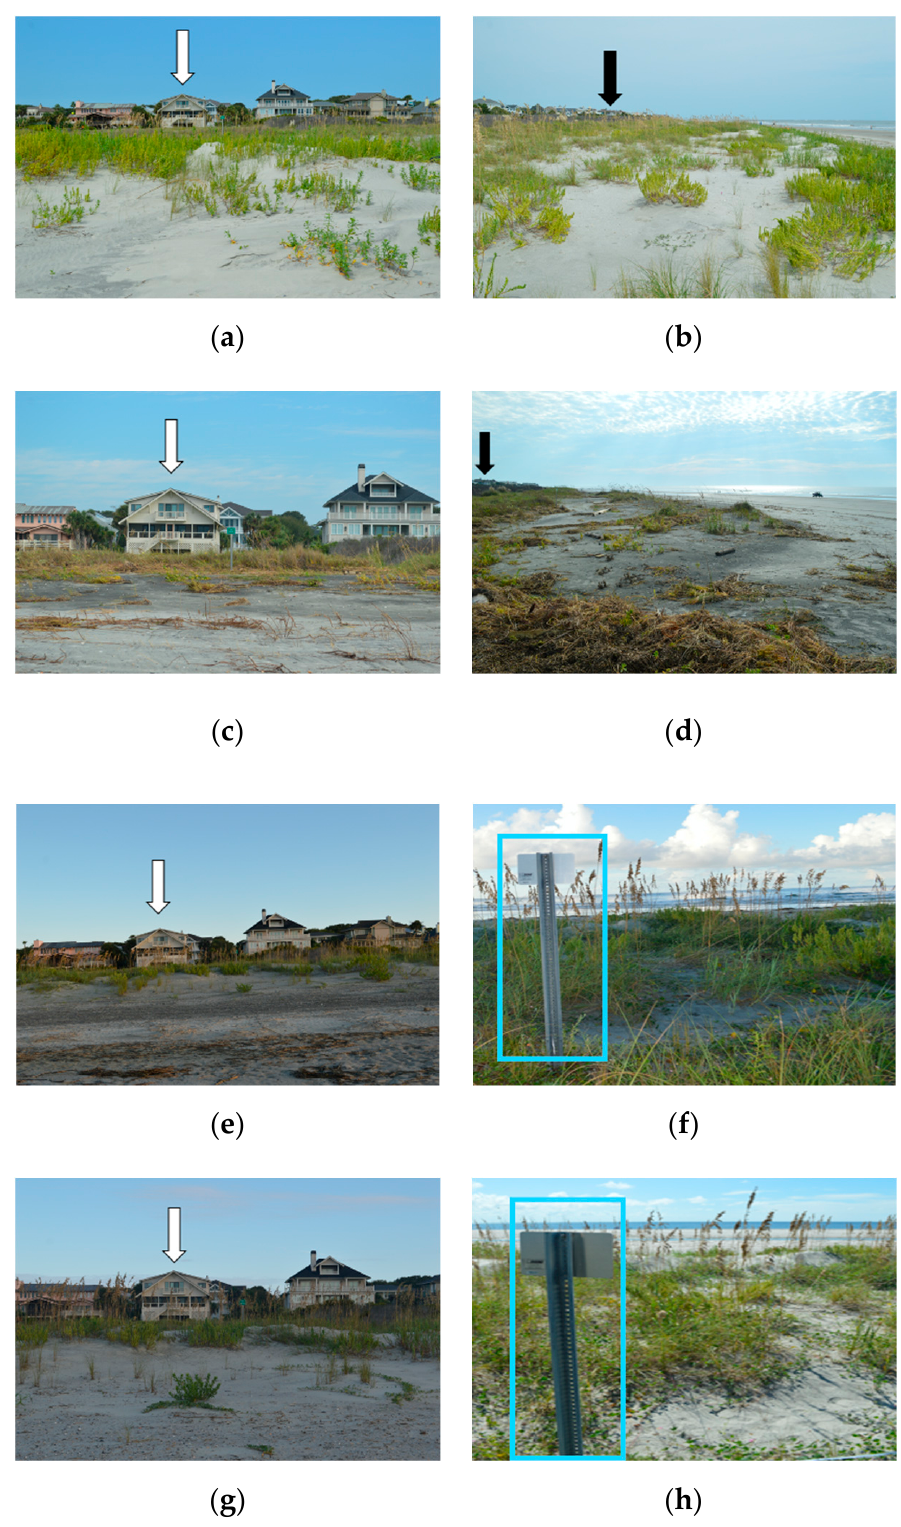
Figure 7. Site B field photographs showing conditions ( a , b ) pre- Irma , ( c , d ) post- Irma , ( e , f ) pre- Florence , and ( g , h ) post- Florence . Symbology denotes anthropogenic or natural locations that are consistent to more than one photograph.